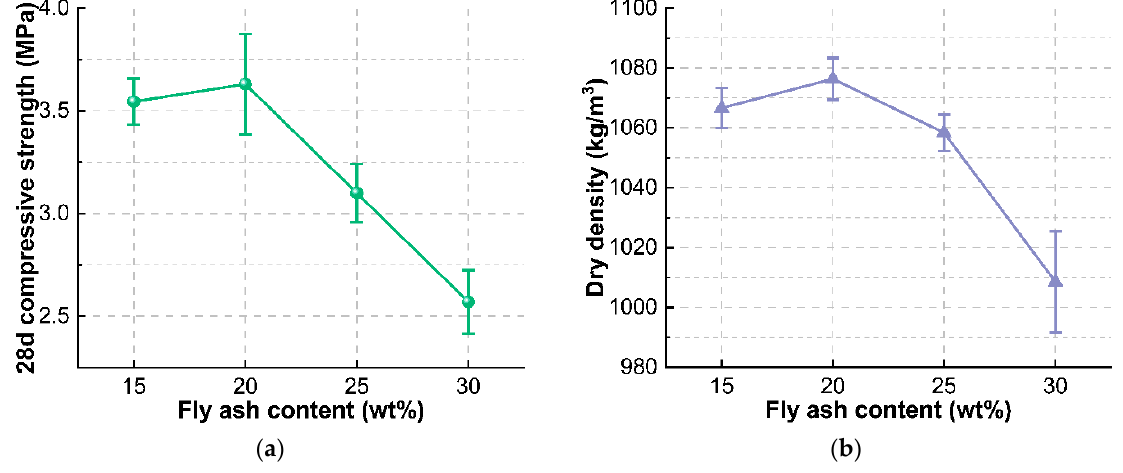
Figure 9. Effect of fly ash content on ( a ) 28 d compressive strength and ( b ) dry density of foamed concrete.